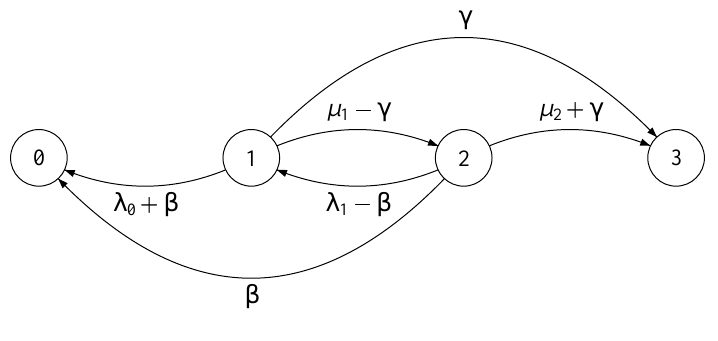
Fig. 2: The dual of the process of Figure